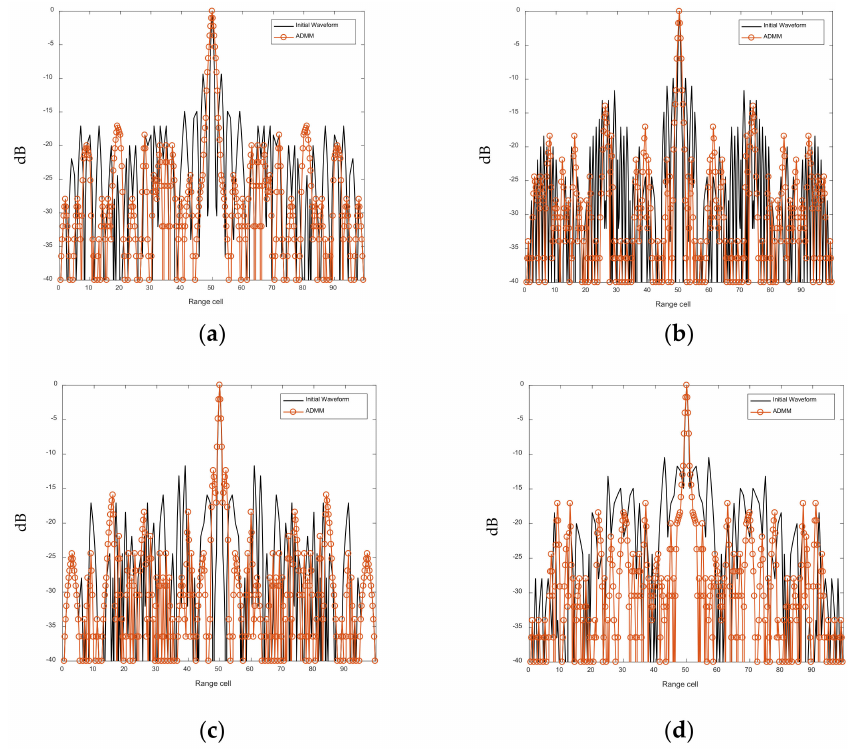
Figure 10. AFs of sub-pulse #1–4 of the FSK-PSK signal before and after optimization. ( a ) AF of Sub-pulse #1. ( b ) AF of Sub-pulse #2. ( c ) AF of Sub-pulse #3. ( d ) AF of Sub-pulse